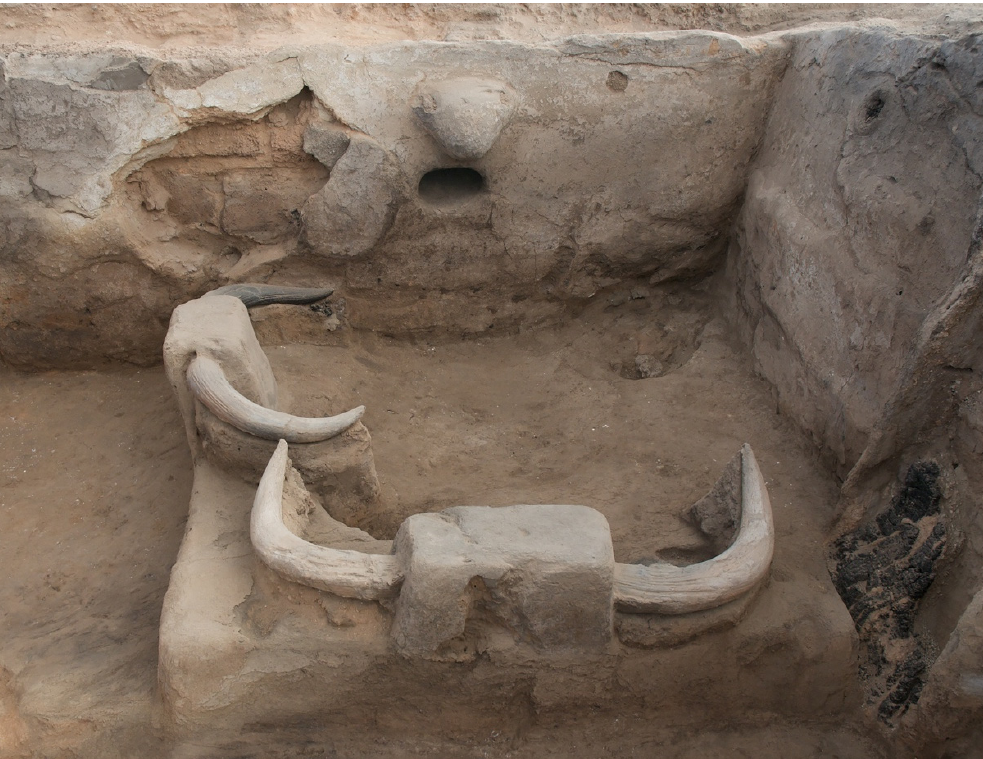
Figure 2. Aurochs horns on pillars on northeast platform in burnt Building 77 (photo by Jason Quinlan, Çatalhöyük Research Project).